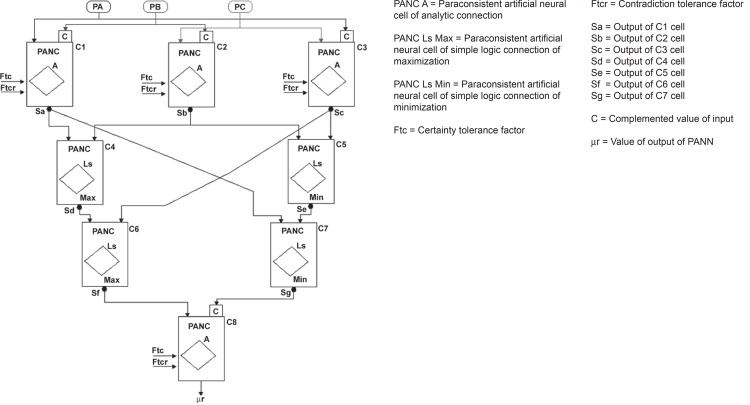
A decision-making architecture for global analysis. Three expert systems operate:
PA, for detecting the diminishing average frequency level; PB, for Alpha band
concentration, and PC, for Theta band concentration.C1–PANC which processes input data of PA and PBC2–PANC which processes input data of PB and PCC3–PANC which processes input data of PC and PAC1, C2, and C3 constitute the 1st
layer of the architectureC4–PANC which calculates the maximum evidence value between cells
C1 and C2C5–PANC which calculates the minimum evidence value between cells
C2 and C3C4 and C5 constitute the 2nd layer of the
architectureC6–PANC which calculates the maximum evidence value between cells
C4 and C3C7–PANC which calculates the minimum evidence value between cells
C1 and C5C6 and C7 constitute the 3rd layer of the
architectureC8 analyzes the experts PA, PB, and PC and gives the resulting
decision value